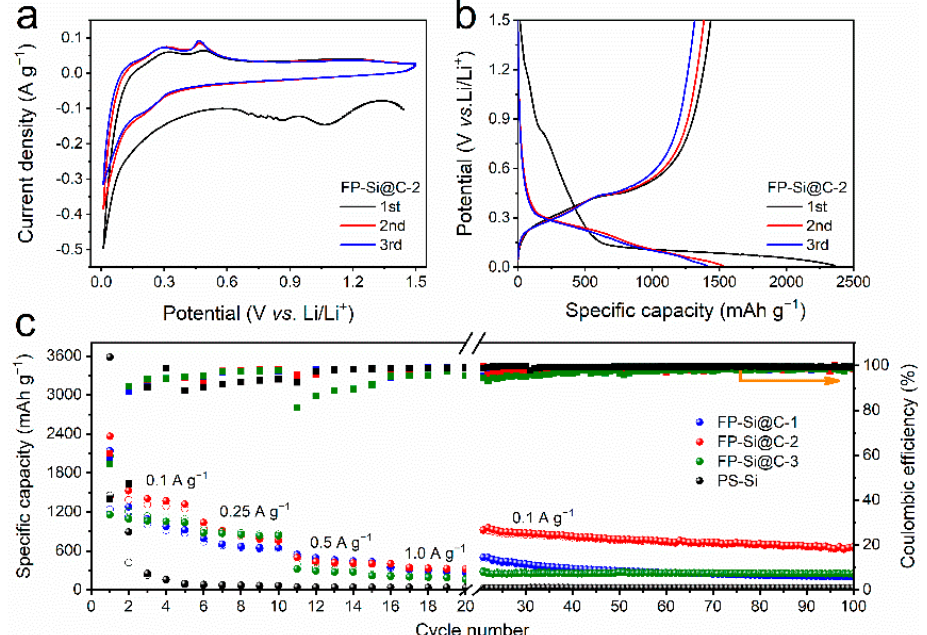
Figure 3. Electrochemical Li+ storage performance of Si-based anodes in half-cells. ( a ) The initial three CV curves of FP-Si@C-2 at 0.1 mV s − 1 ; ( b ) initial three GCD curves of FP-Si@C-2 at 0.1 A g − 1 ; ( c ) rate capability and long-term cycling stability of P-SiCW, FP-Si@C-1, FP-Si@C-2, and FP-Si@C-3.